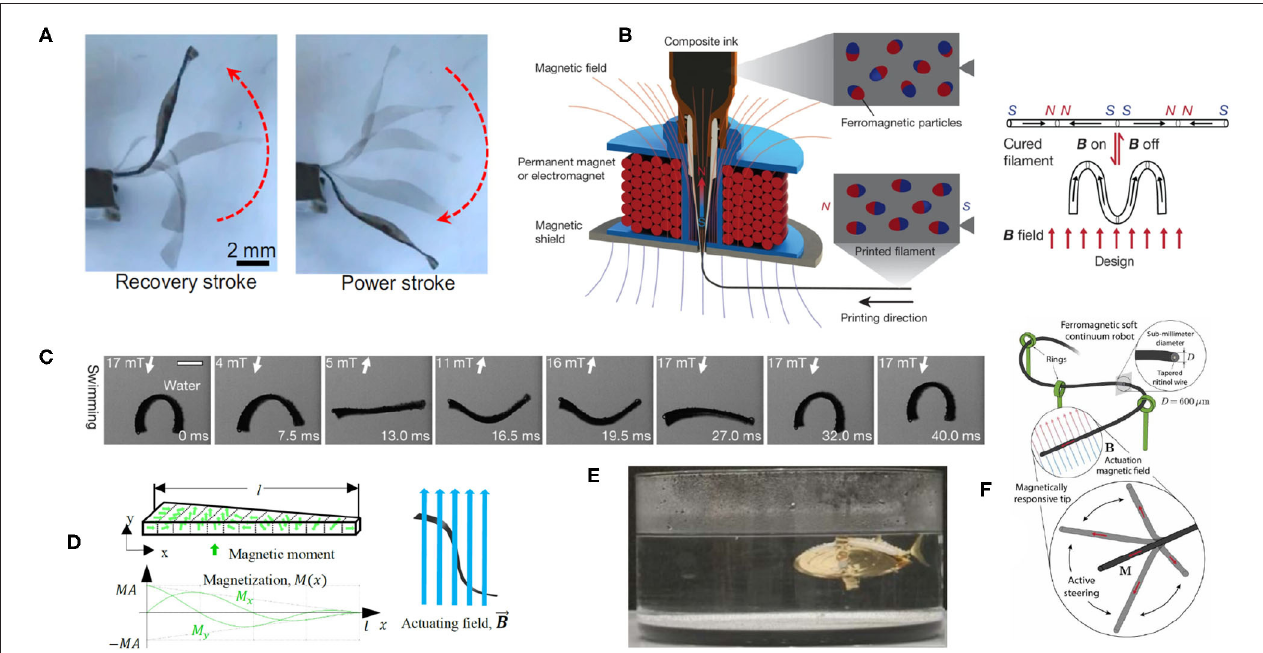
FIGURE 2 | A compilation of hMEs and their soft robotic applications: (A) a bending hME actuator, controlled by the application of a magnetic field (Lum et al., 2016), (B) 3D printer head with electromagnet around the nozzle to program magnetic domains of the extruded hME throughout the print (Kim et al., 2018), (C) soft swimmer with varying applied fields to enable shape change and a swimming gait ( Hu et al., 2018), (D) a triangular tail soft swimmer with varying magnetic domains to enable an undulating swimming motion ( Manamanchaiyaporn et al., 2020), (E) origami-inspired folded fish robot swimming utilizing remote magnetic guidance (Sung et al., 2017), and (F) steerable hME-based wire, guided remotely (Kim et al.,